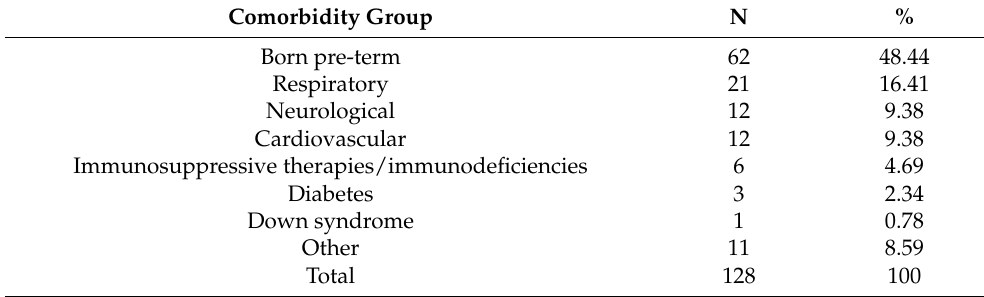
Table 2. Chronic conditions grouped by type (N = 128). Pedianet, 2016–2021.